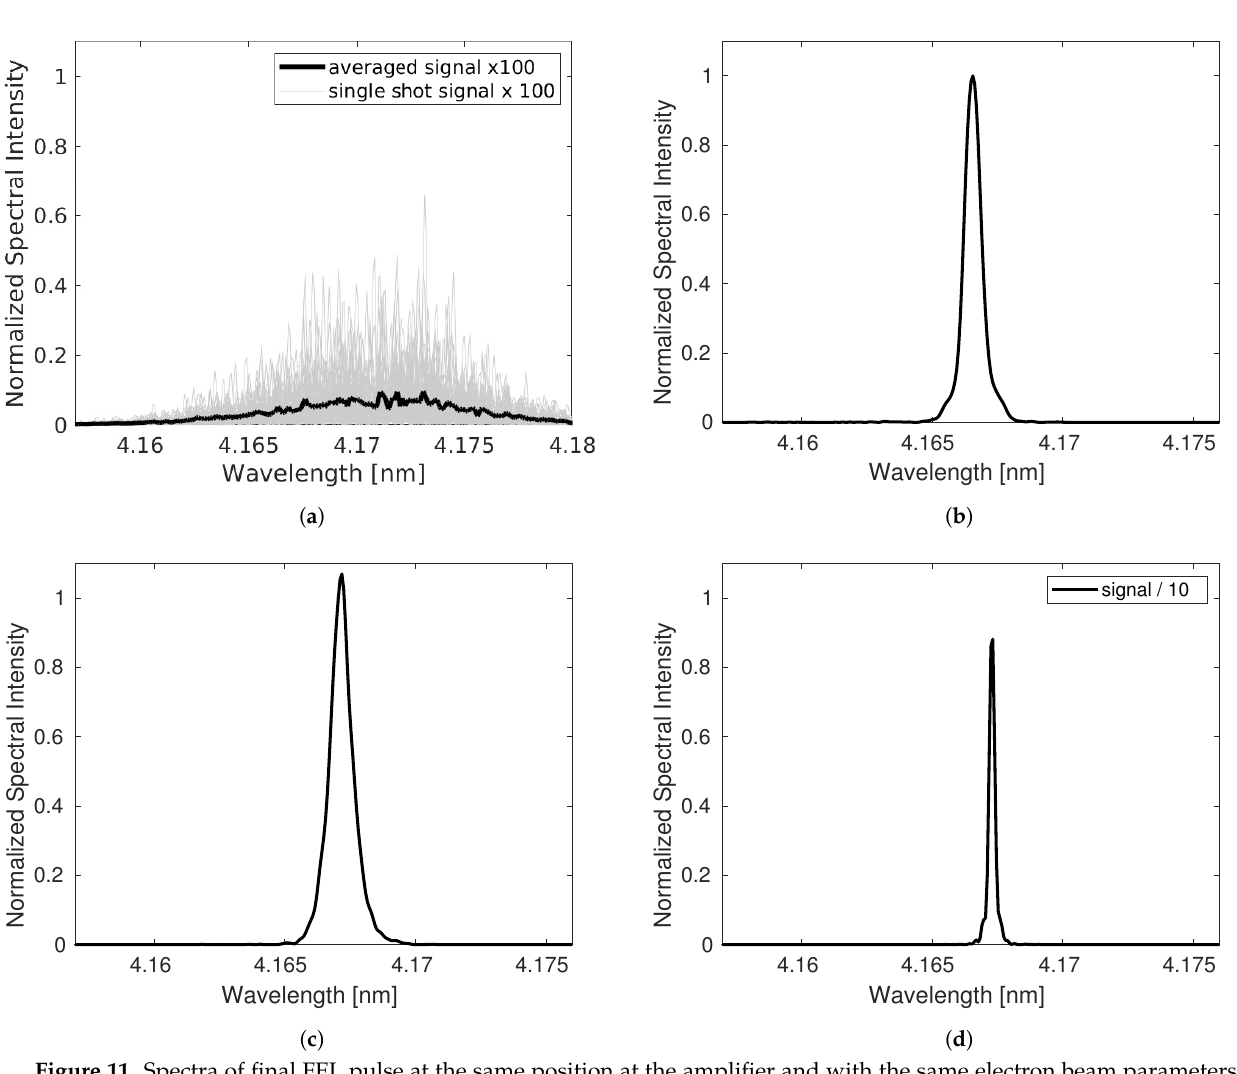
Figure 11. Spectra of final FEL pulse at the same position at the amplifier and with the same electron beam parameters shown at Table 1. The spectral intensity is normalized to the peak intensity calculated at the standard single-pass HGHG simulation. ( a ) SASE. Please notice the extended horizontal axis. The average SASE spectrum over 50 shots is shown with the black line. ( b ) Standard HGHG in a single-pass. ( c ) Oscillator-FEL starting with an external seed laser pulse. ( d ) Oscillator-FEL starting from